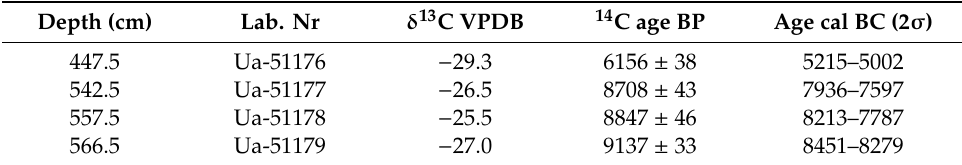
Table 1. 14 C-dates dates from the Lake Boren sediment